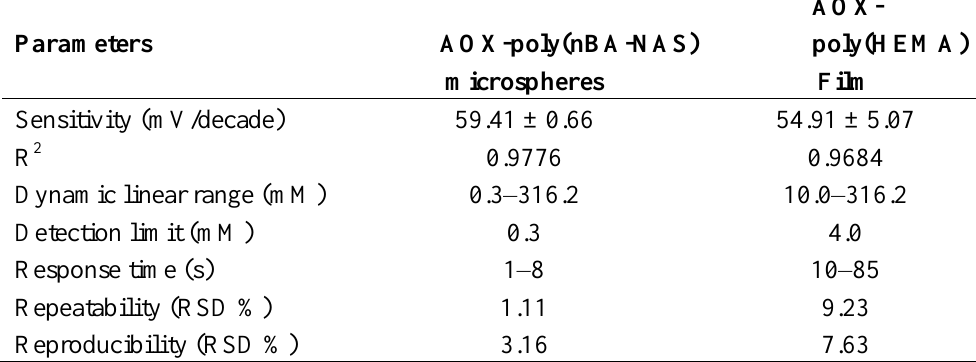
Table 5. Comparison of analytical performance between formaldehyde biosensors